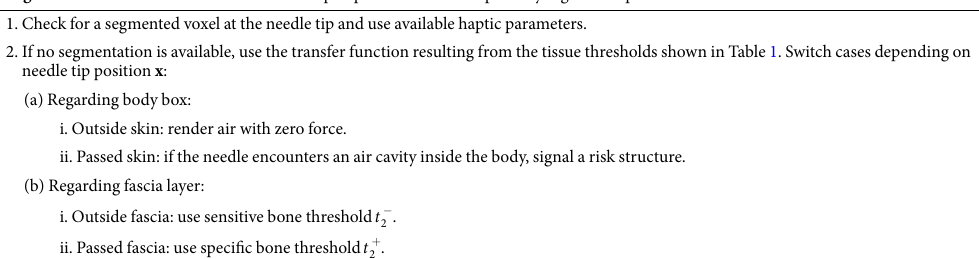
simulated and visualized in the X-ray viewport (Fig. 9(2)). US guidance (Fig. 9(3)) effectively helps to puncture the target structure correctly and is very commonly used by physicians in this challenging puncture intervention.